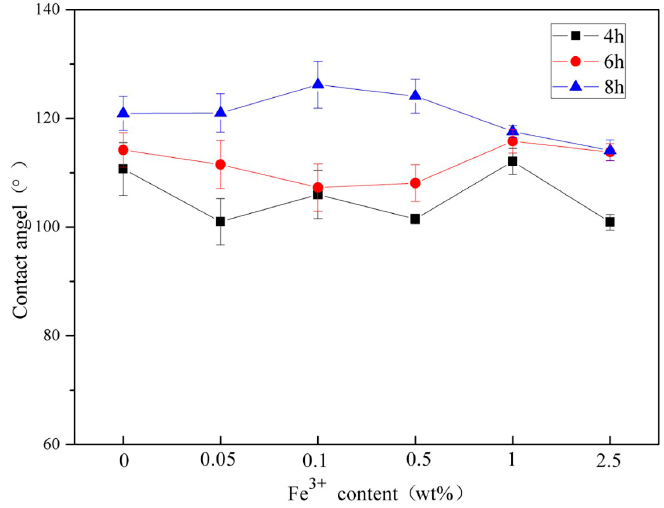
Figure 12. Wetting performance of composite films coated on wood with different Fe 3+ doping as well as with different immersion times.